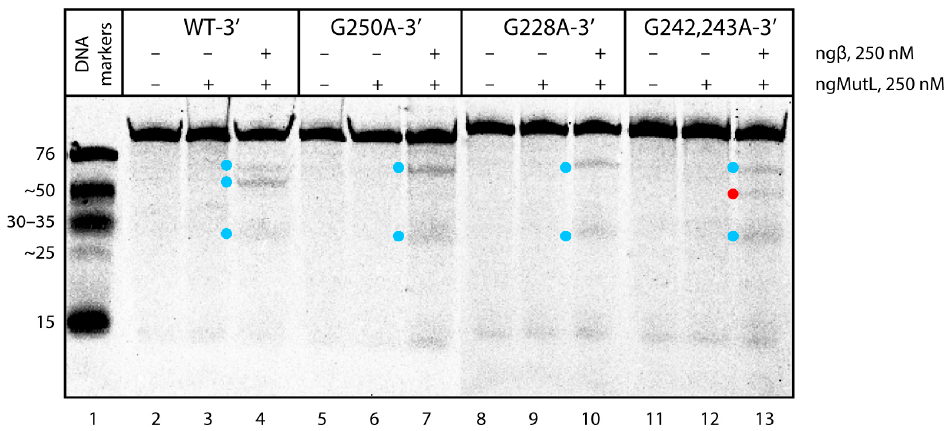
Figure 9. The ngMutL-induced hydrolysis of WT-3 (cid:48) hTERT G4 and its altered forms. The reaction conditions are the same as in the legend in Figure 8; 250 nM ngMutL (per dimer) was used in the presence of an equimolar amount of ng β dimer. The lengths of DNA markers (in nucleotide residues) are shown on the left; TAMRA-labeled DNA cleavage products are indicated by blue and red